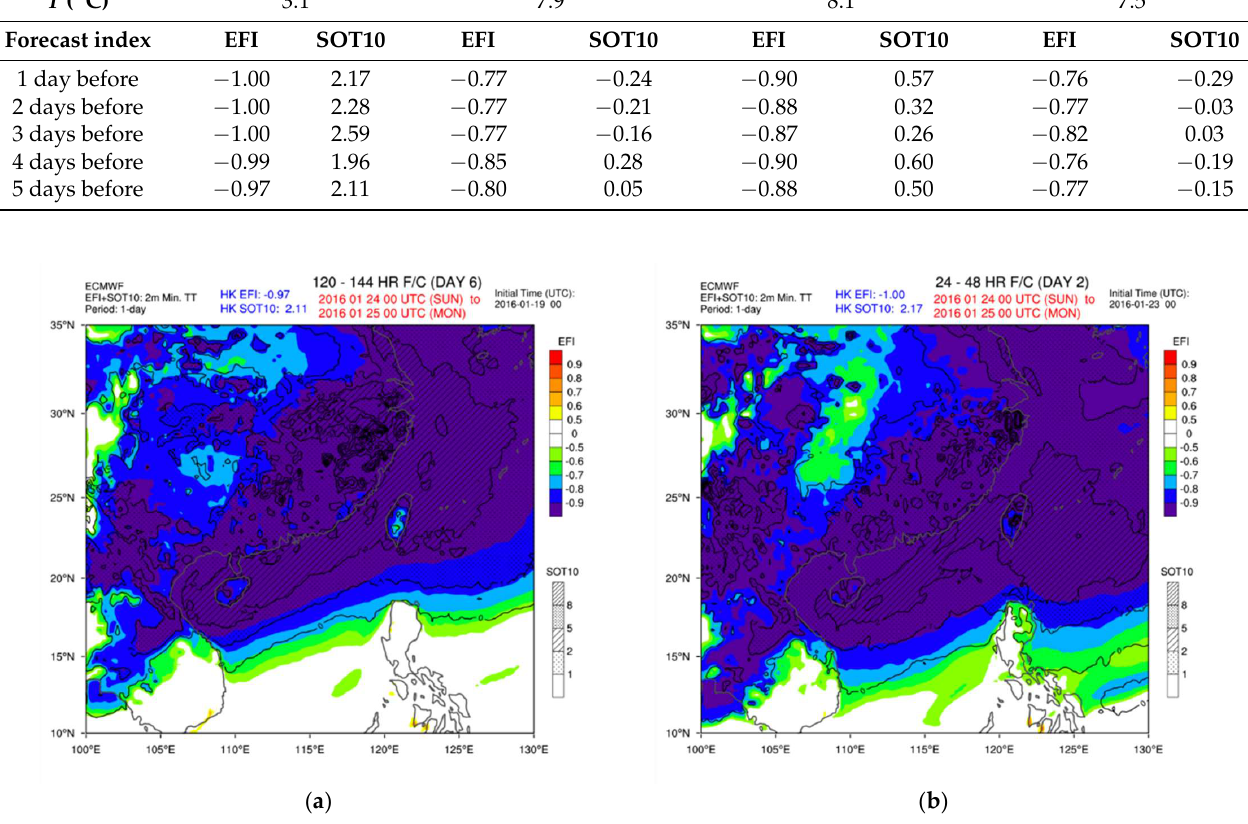
Figure 13. ECMWF Extreme Forecast Index (EFI, color) and Shift of Tail Index for the 10th percentile (SOT10, hatched) for 2 m minimum temperature from 00 UTC on 24 January to 00 UTC on 25 January 2016 based on ( a ) 00 UTC run of 19 January 2016 and ( b ) 00 UTC 23 January 2016.